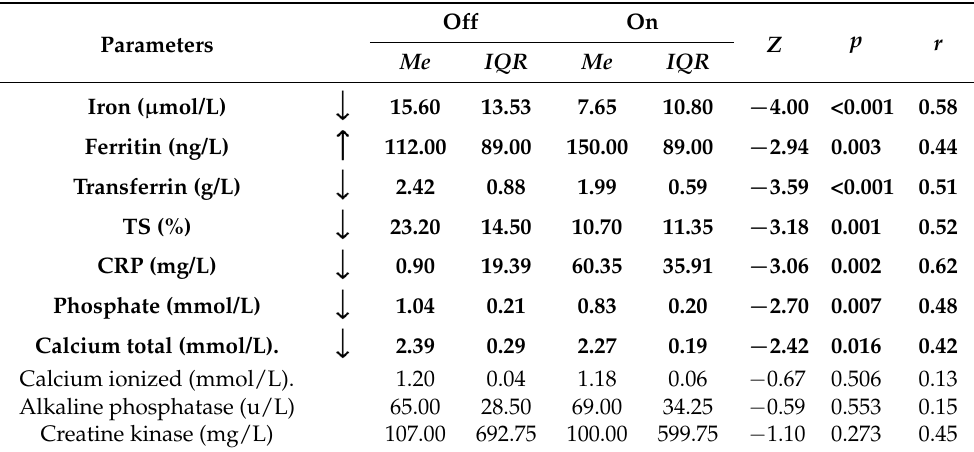
Table 1. Comparison of selected biochemical parameters before and after electrical stimulation in DBS and SCS groups. Parameters in bold were significantly different. Trend arrows show the change of examined parameters.